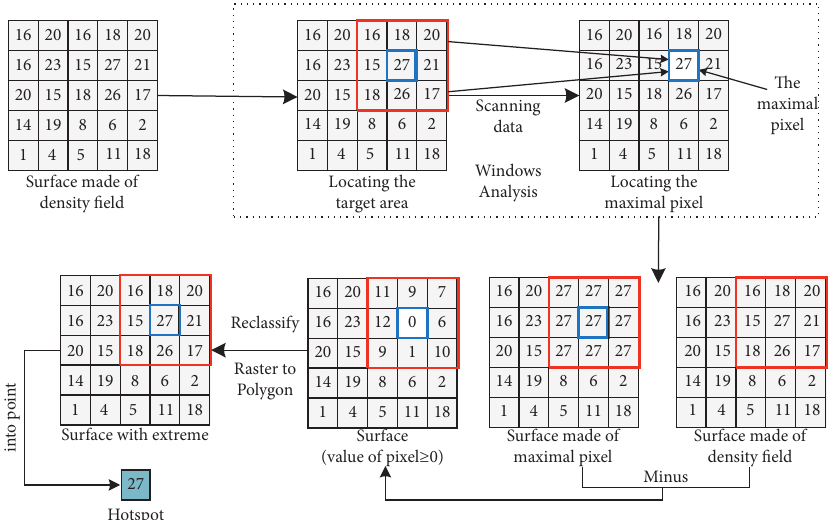
Figure 4: Demonstration of hotspot detection.